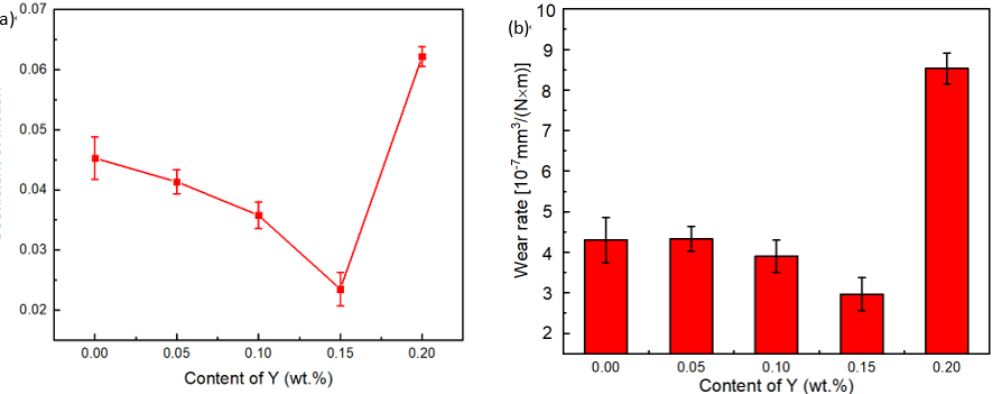
Figure 3. Evolution of the ( a ) coefficient of friction and( b ) wear rate with increasing content of Y.